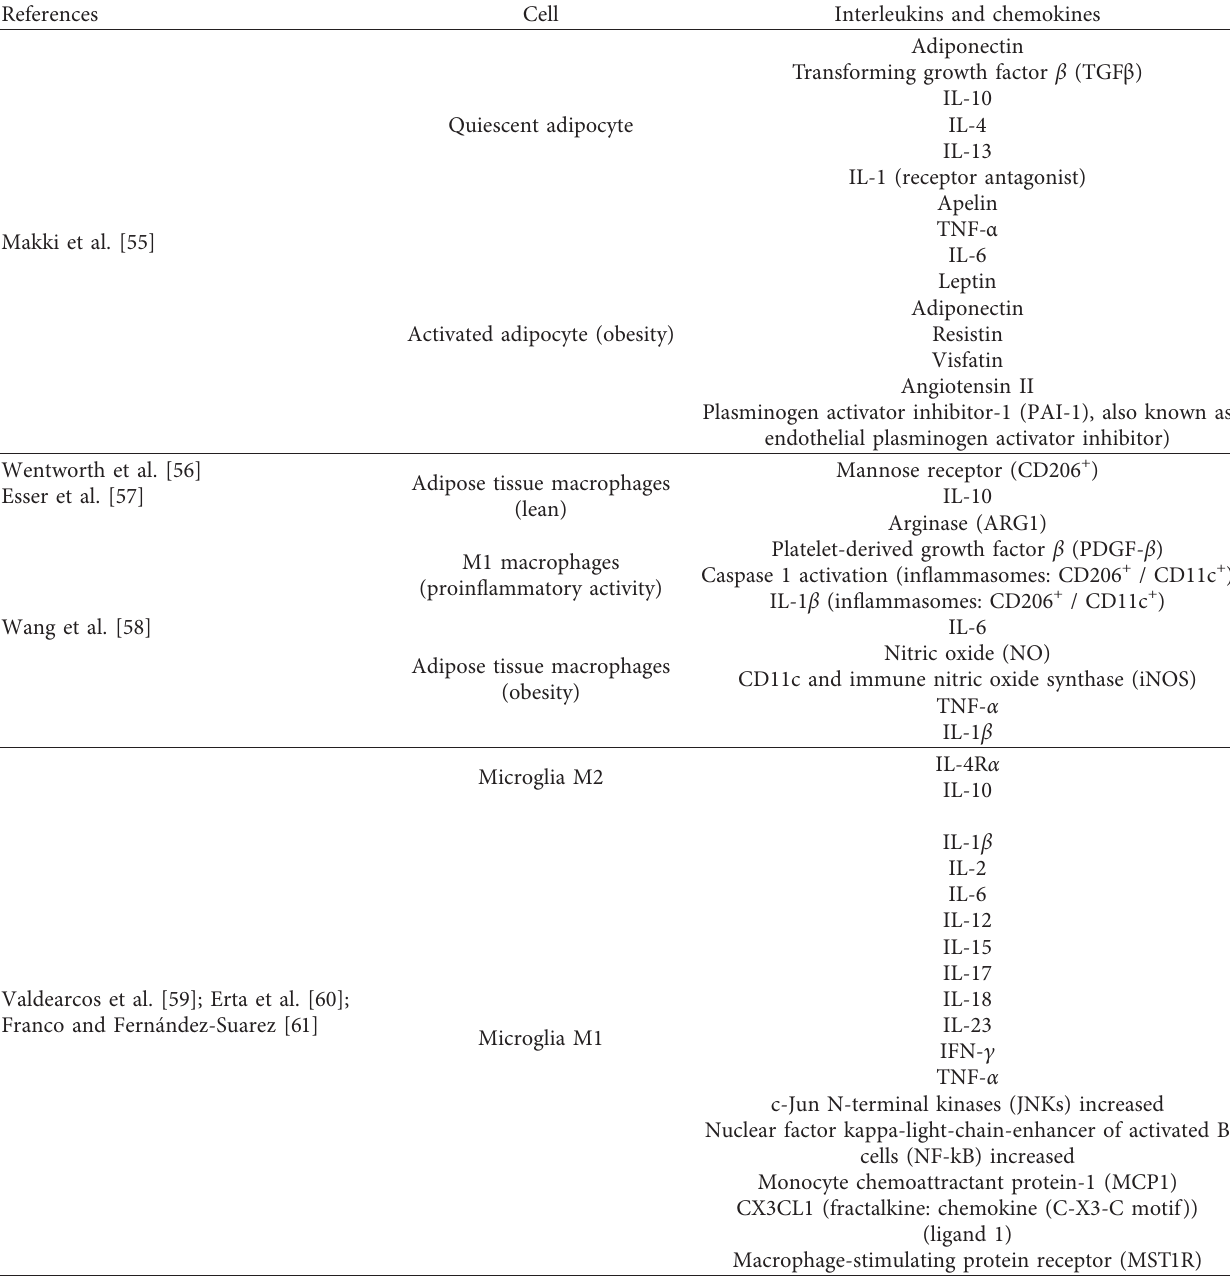
Table 1: Cytokines and chemokines outside CNS and in relation with